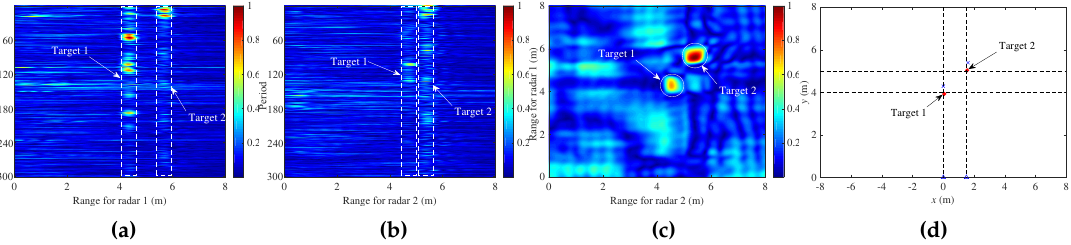
Figure 16. Results of Experiment 3.1: ( a ) range profile plane for Radar 1; ( b ) range profile plane for Radar 2; ( c ) cross-correlation image; and ( d ) localization result.